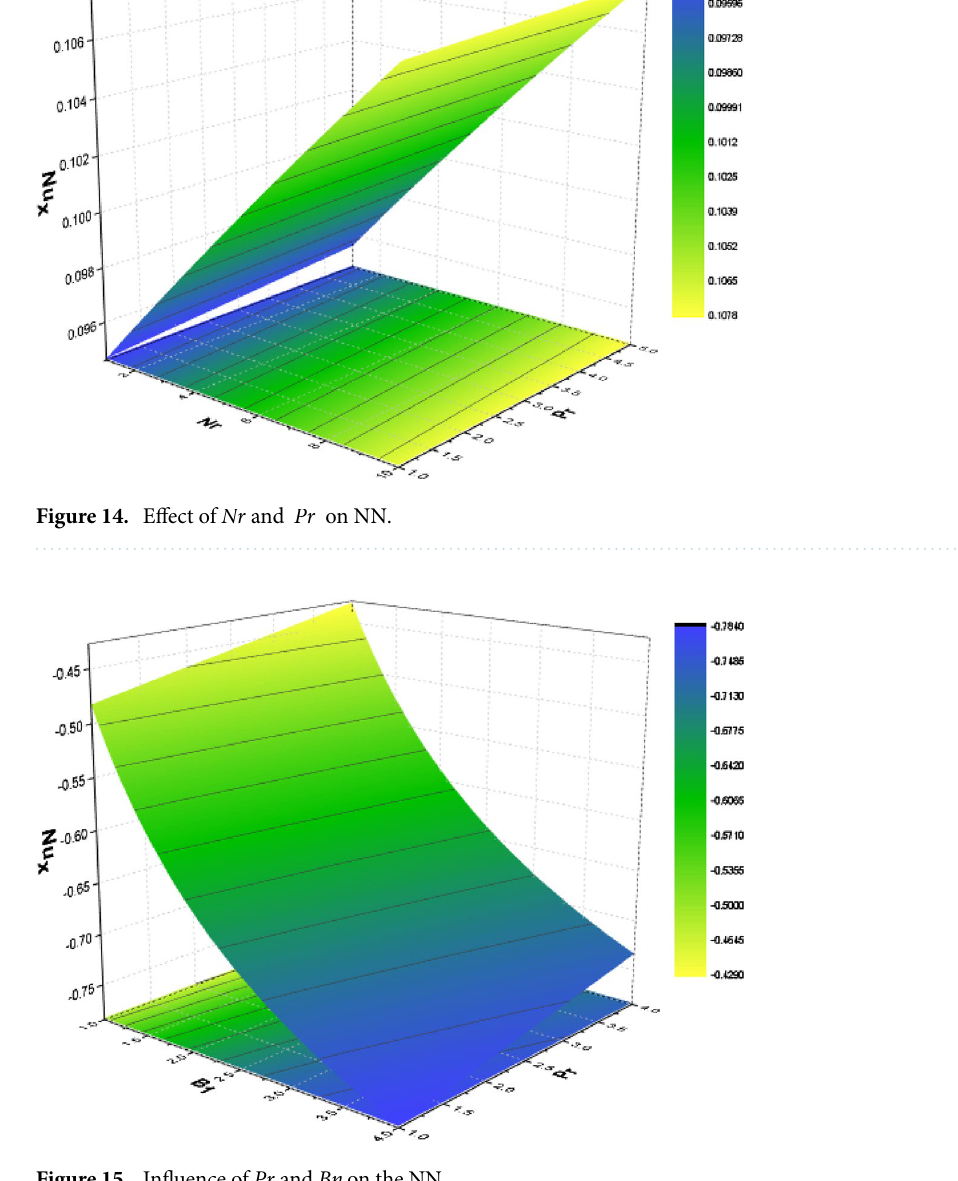
Figure 15. Influence of Pr and Bn on the